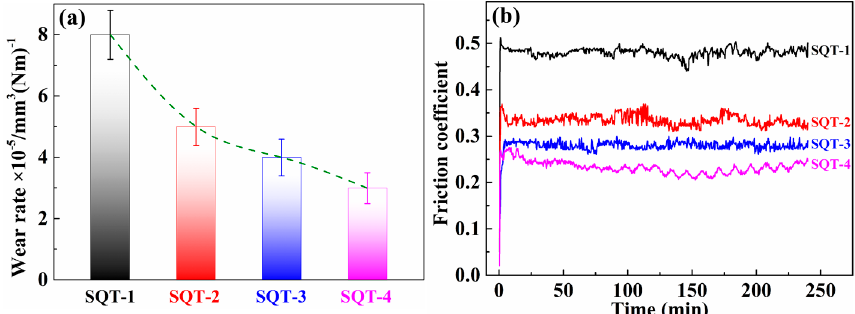
Figure 10. ( a ) Wear rates and ( b ) friction coefficient curves of RQT specimens.